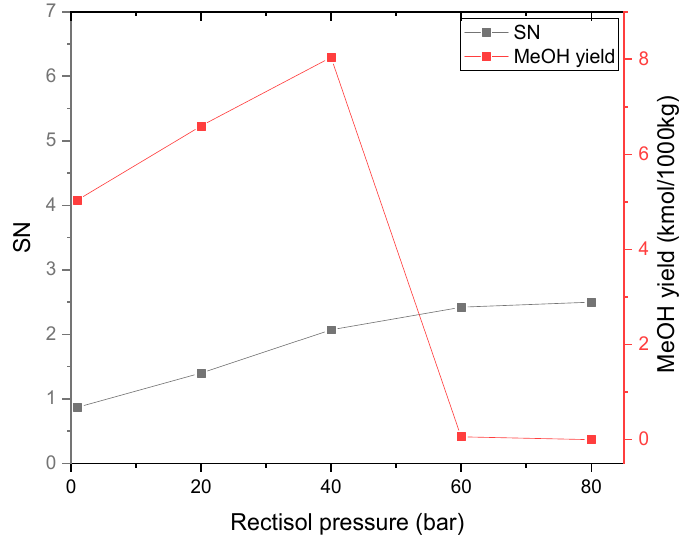
Figure 9. E ff ect of Rectisol pressure on SN and methanol yield ( − 20 ◦ Figure 9. Effect of Rectisol pressure on SN and methanol yield ( − 20 °C).